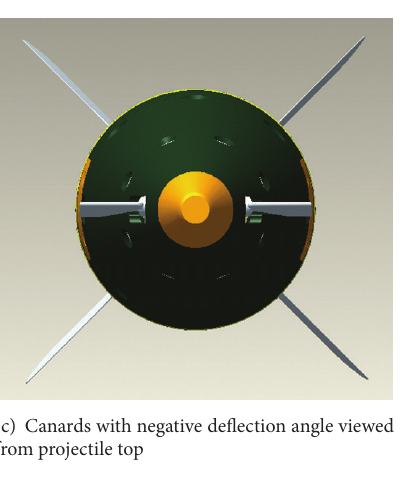
Figure 2: Schematic of canards.